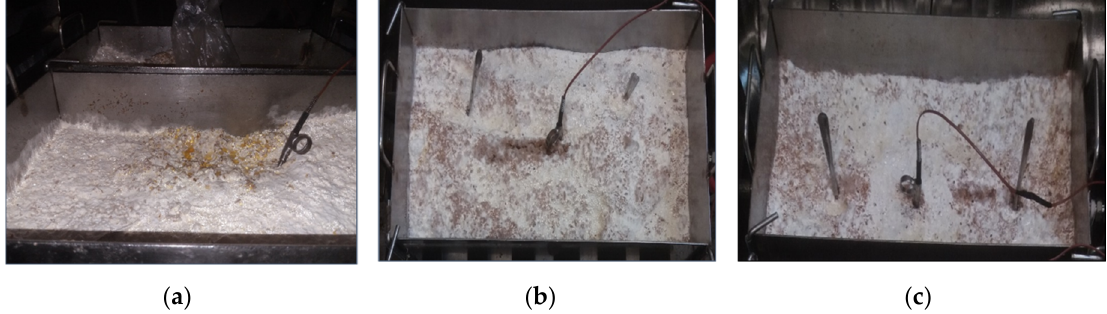
Figure 2. Colonization of the substrate based on coffee husk, corn bran, and oak sawdust by T. versicolor in a fixed-bed solid-state bioreactor. Surface of the colonized substrate beds after 14 cultivation days under low aeration level ( a ), high aeration level ( b ), and natural convection ( c ).